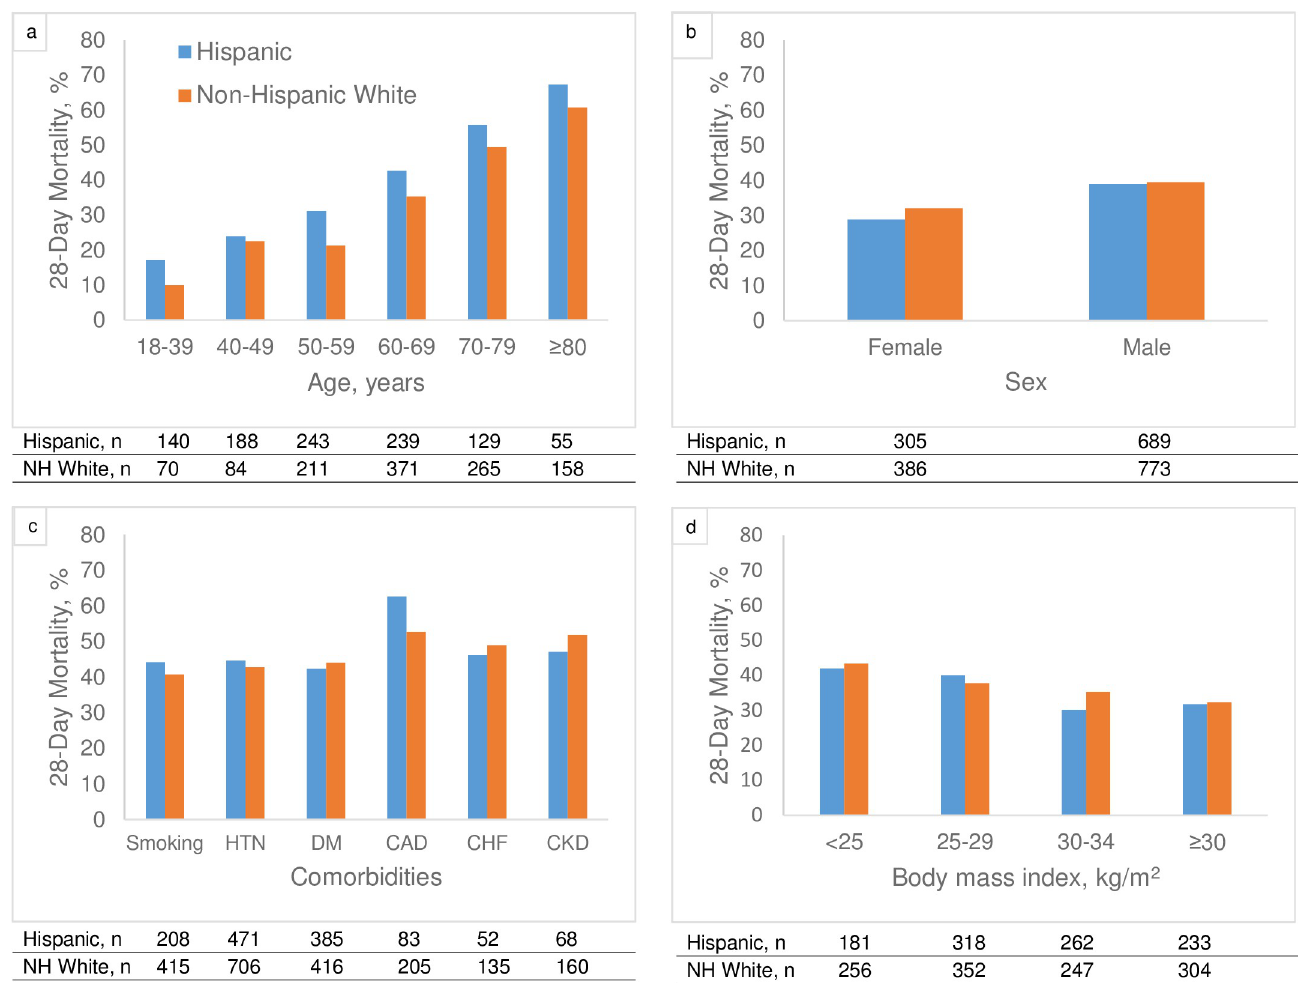
Fig 1. Unadjusted mortality rate by ethnicity, and pre-specified subgroups. Twenty-eight-day mortality by (a) age group, (b) sex, (c) comorbidities, and (d) body mass index. Abbreviations: CAD, coronary artery disease; CHF, congestive heart failure; CKD, chronic kidney disease; DM, diabetes; HTN, hypertension.